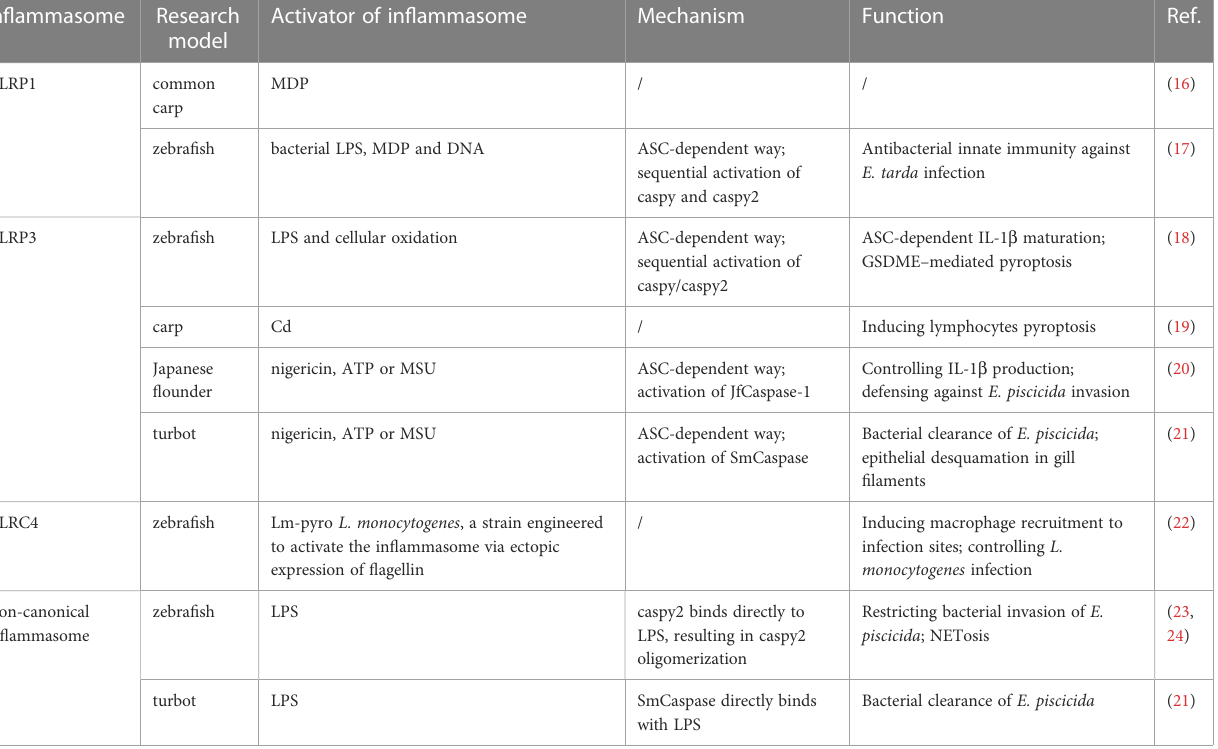
TABLE 1 Summary of in fl ammasomes in teleost fi sh. In fl